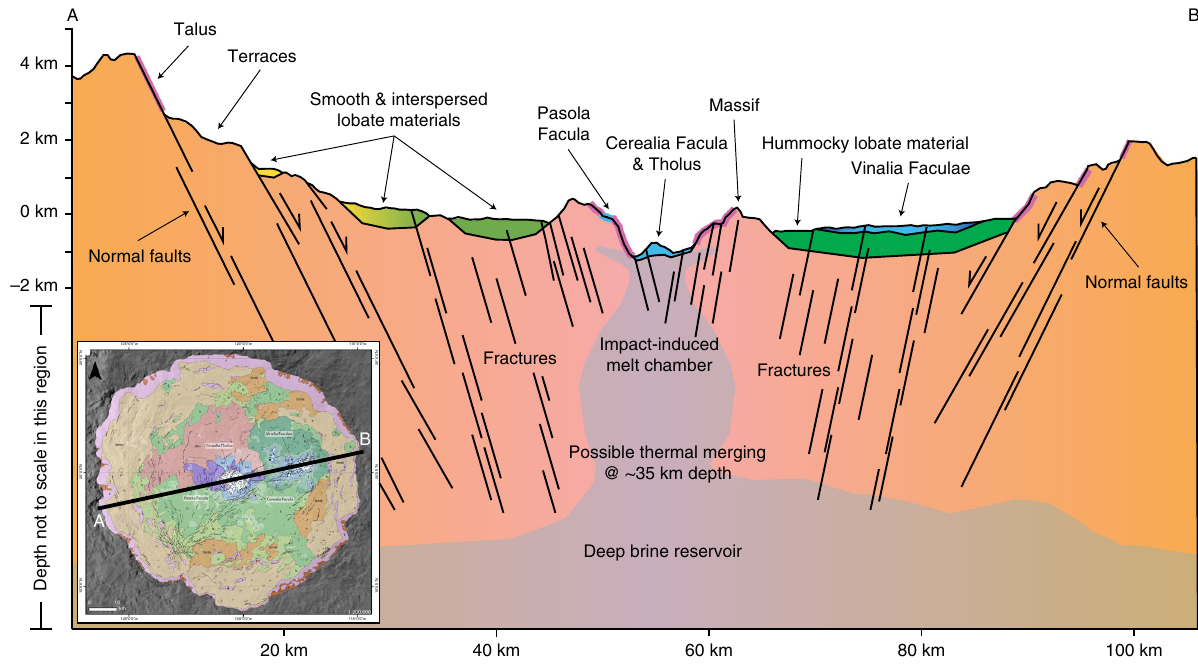
Fig. 5 Cross section through Occator crater, including schematic subsurface structure. The colors shown in this fi gure correspond to the geologic units (as de fi ned in Fig. 1a) and key features are labeled. This fi gure does not illustrate a particular time-step in Occator ’ s evolution. Impact-derived fractures form conduits to source the faculae-forming brines, and the impact-induced melt chamber thermally connects to the deep brine reservoir. The sizes and depths of the impact-induced melt chamber and deep brine reservoir are schematic, and are based on refs. 9, 30, 32, 49 . We do not show the warping of the lobate material by the formation of the central pit in the cross section, because it is out of the plane, which was chosen to show the key features in the crater. The pro fi le is taken from the LAMO DTM 59 , and the line of the pro fi le is shown in the inset